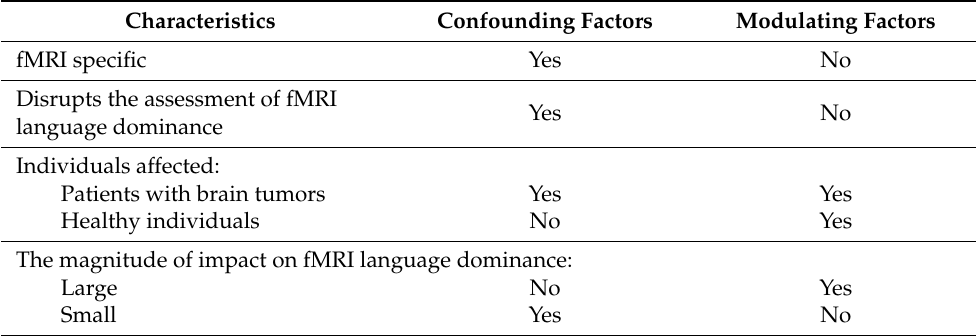
Table 1. Differences between confounding and modulating factors in affecting fMRI estimates of language